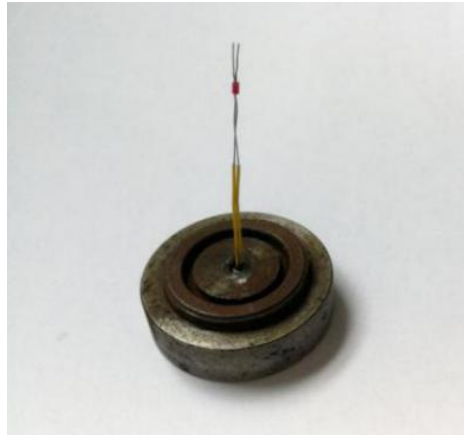
Figure 34. Arming safety test tooling.